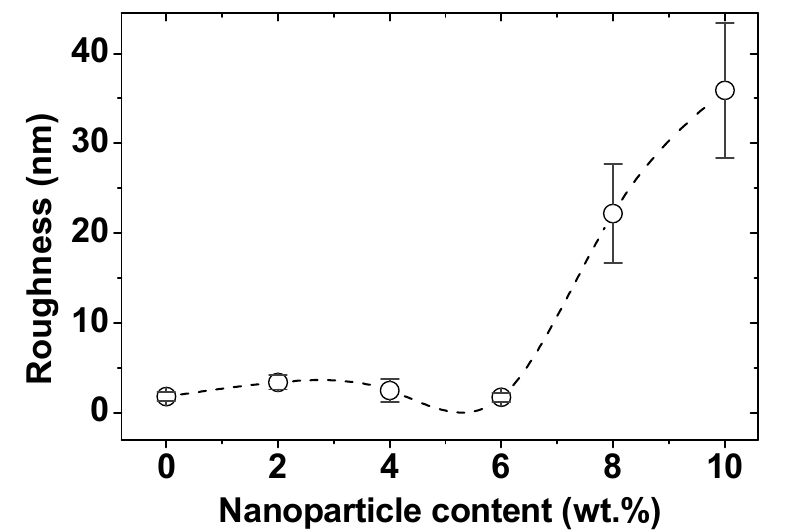
Figure 6. Average surface roughness of nanocomposites.